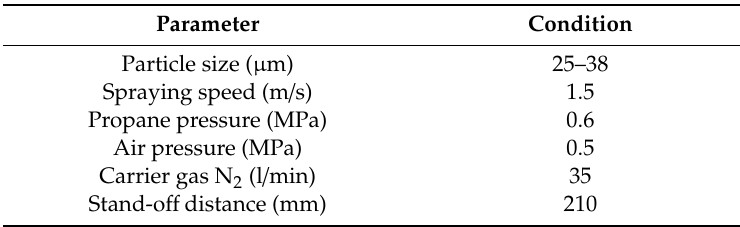
Table 1. Spraying